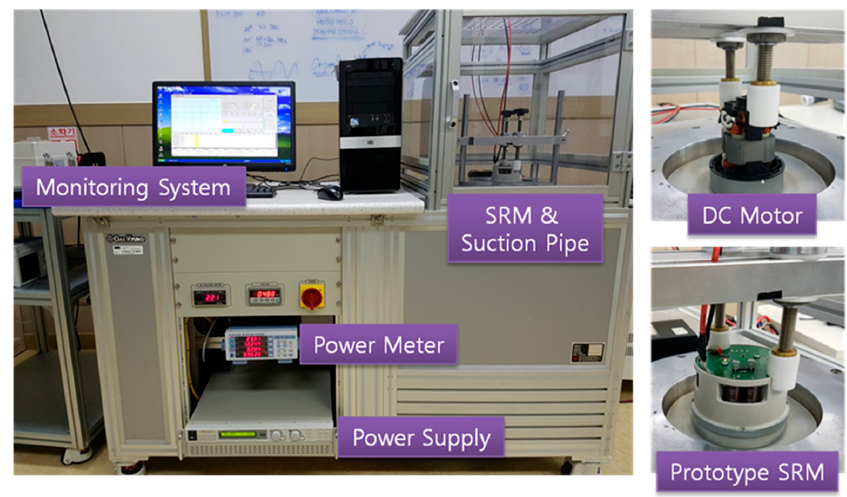
Figure 21. Suction power tester and DC motor/SRM sample.